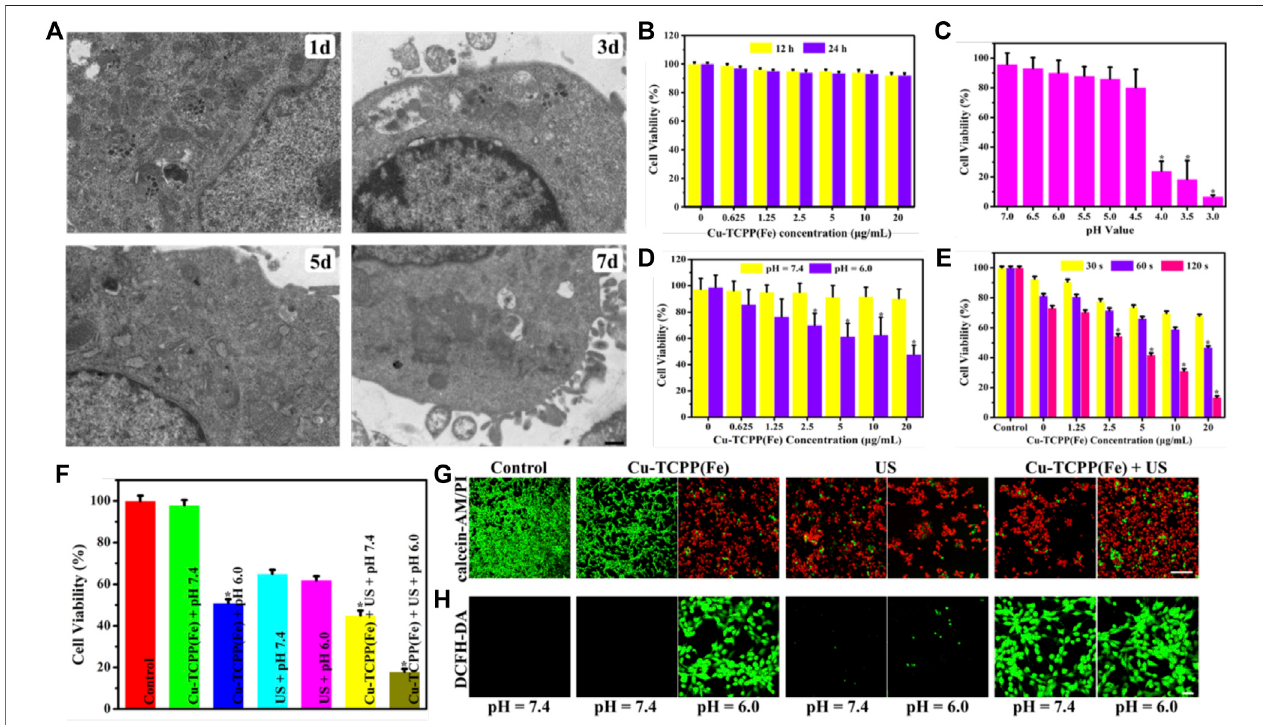
FIGURE 5 | In vitro SDT/chemical catalysis therapy for cancer. (A) Bio-TEM images for the intracellular biodegradation behavior of Cu-TCPP(Fe) in 4T1 cells after co-incubation over time (Chu and Dupuy, 2014;Liu et al., 2015a; Pelaz et al., 2017; Siegel et al., 2021) (D) . (B) Viability of 4T1 cells after incubation with various concentrations of Cu-TCPP(Fe) for 12 and 24 h. (C) Viability of 4T1 cells after incubation at various pH values (7.0, 6.5, 6.0, 5.5, 5.0, 4.5, 4.0, 3.5 and 3.0) for 12 h. (D) Cytotoxicity pro fi les of 4T1 cells treated with Cu-TCPP(Fe) under neutral (pH = 7.4) and acidic (pH = 6.0) conditions. (E) Viability of 4T1 cells after exposure to US irradiation (1.0 MHz, 1.5 W/cm 2 , 50%duty cycle) over time (30, 60,and 120 s) at various Cu-TCPP(Fe) concentrations (20, 10, 5, 2.5, 1.25 μ g/ml). (F) Relative viabilities of4T1cellsafterdifferenttreatments,includingcontrol(withoutanytreatment),Cu-TCPP(Fe)atpH=7.4/6.0,USirradiationatpH=7.4/6.0,andCu-TCPP(Fe)combined with US irradiation at pH = 7.4/6.0. CLSM images of 4T1 cells stained with calcein AM/PI solution (G) and the ROS fl uorescent probe DCFH-DA (H) after different treatments (scale bar: 50 μ m). * p < 0.05, calculated by one-way ANOVA